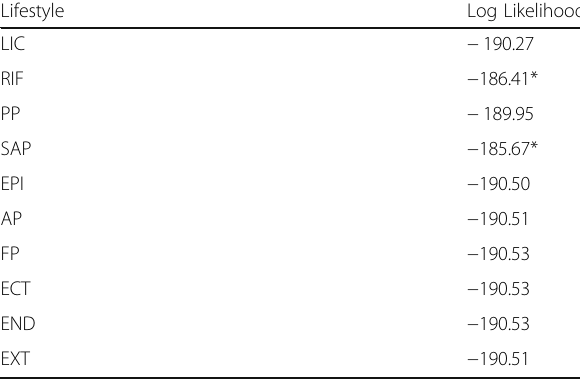
Table 2 Ancestral character state reconstruction Log Likelihood values for the basal node of the “ >1Kb Gblocks ” dataset phylogeny. The states estimated to be the best according to the Likelihood threshold are marked with an asterisk. LIC: lichen;